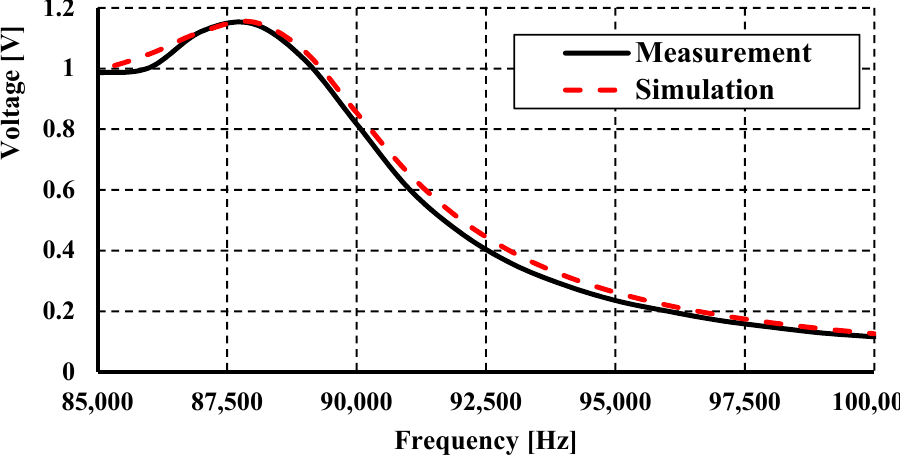
Figure 10. EM radiation verification—induced voltage level on measuring coil at 20 mm distance (Non-Shielded wireless power transfer (WPT) system).